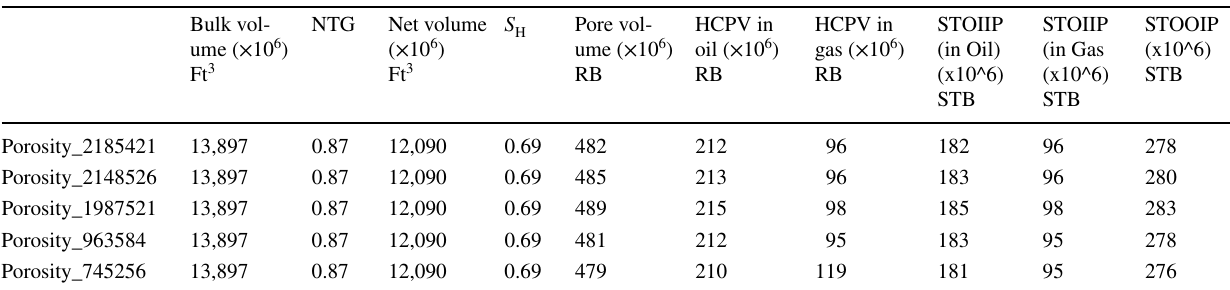
Table 1 Volumetric result for